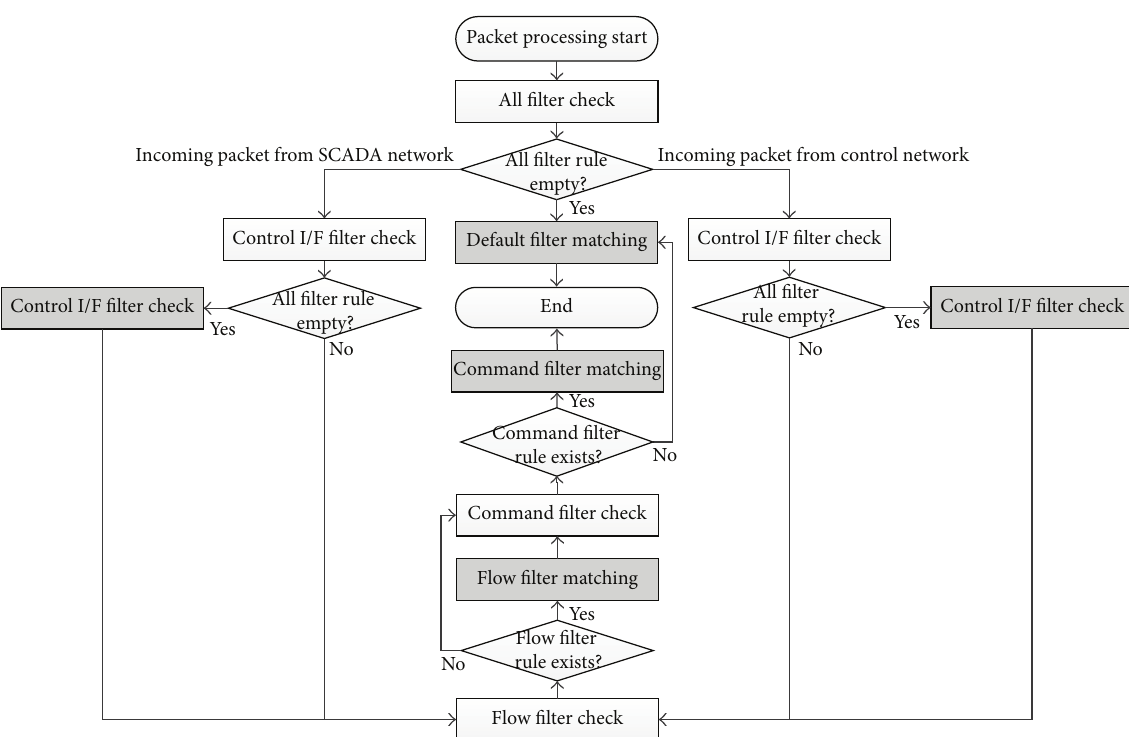
Figure 7: Overall packet processing flow through multiple access control